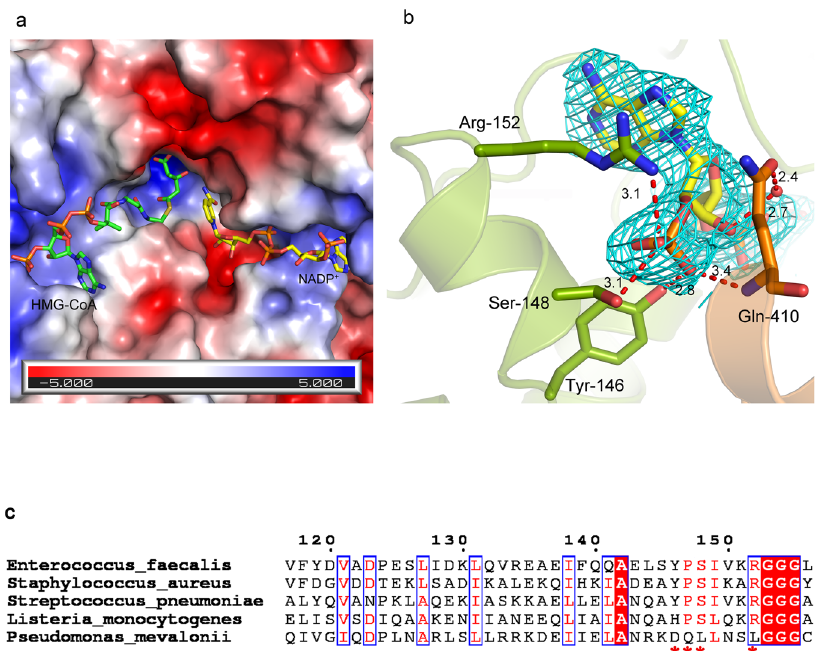
Fig. 2 Structural determinants of NADP + in efHMGR. a Electrostatic surface potential map of efHMGR with NADP + and HMG-CoA bound in the active site. Both HMG-CoA (green) and NADP + (yellow) are represented as sticks. b Tyr-146, Ser-148 and Arg-152 residues represent the molecular determinants present in the small domain of efHMGR that interact with the oxygen atoms of the 2'-ribose-phosphate group of NADP + . Gln-410 originating from the fl ap also interacts with NADP + . The NADP + molecule is encased in a 2Fo-Fc difference density at 1.0 σ . Hydrogen bond interactions are represented as red dashes and the distances are shown in Å. c Class II HMGRs of S. pneumoniae, S. pyogenes, S. aureus and E. faecalis utilize NADPH as the cofactor. The residues (marked with an asterix) that determine the cofactor speci fi city are conserved in these bacterial enzymes including efHMGR. The P. mevalonii HMGR, which utilizes NADH has Asp-146, Leu-148 and Leu-152 as the molecular